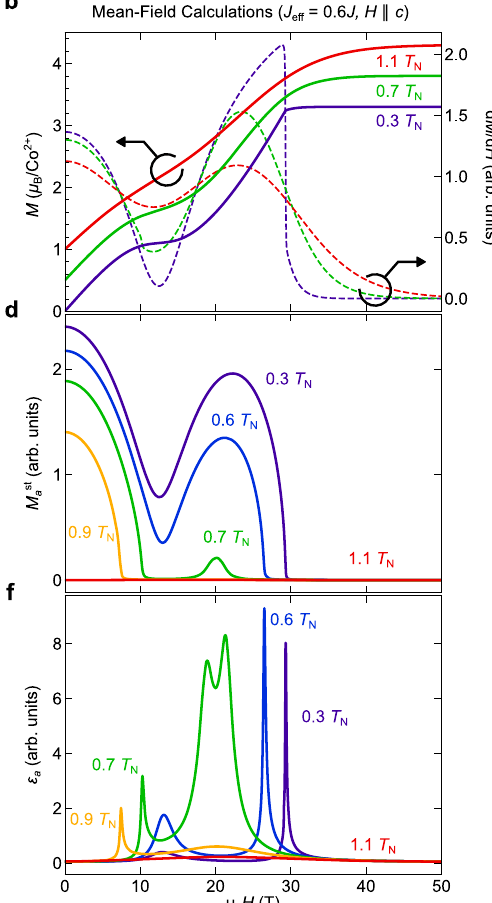
determinedfromthe fi eldderivativeof ε a (seeSupplementaryNote2).Broadpeaks around22Tathighertemperaturesaremarkedbytheblue-opentriangles. b , d ,and f Calculated fi eld dependences of M , staggered magnetization M st a of a -axis com- ponent, and ε a . Temperatures are normalized by the T N ( H =0). The scale factor for the interaction term J is set to 0.6. See “ Methods ” for the